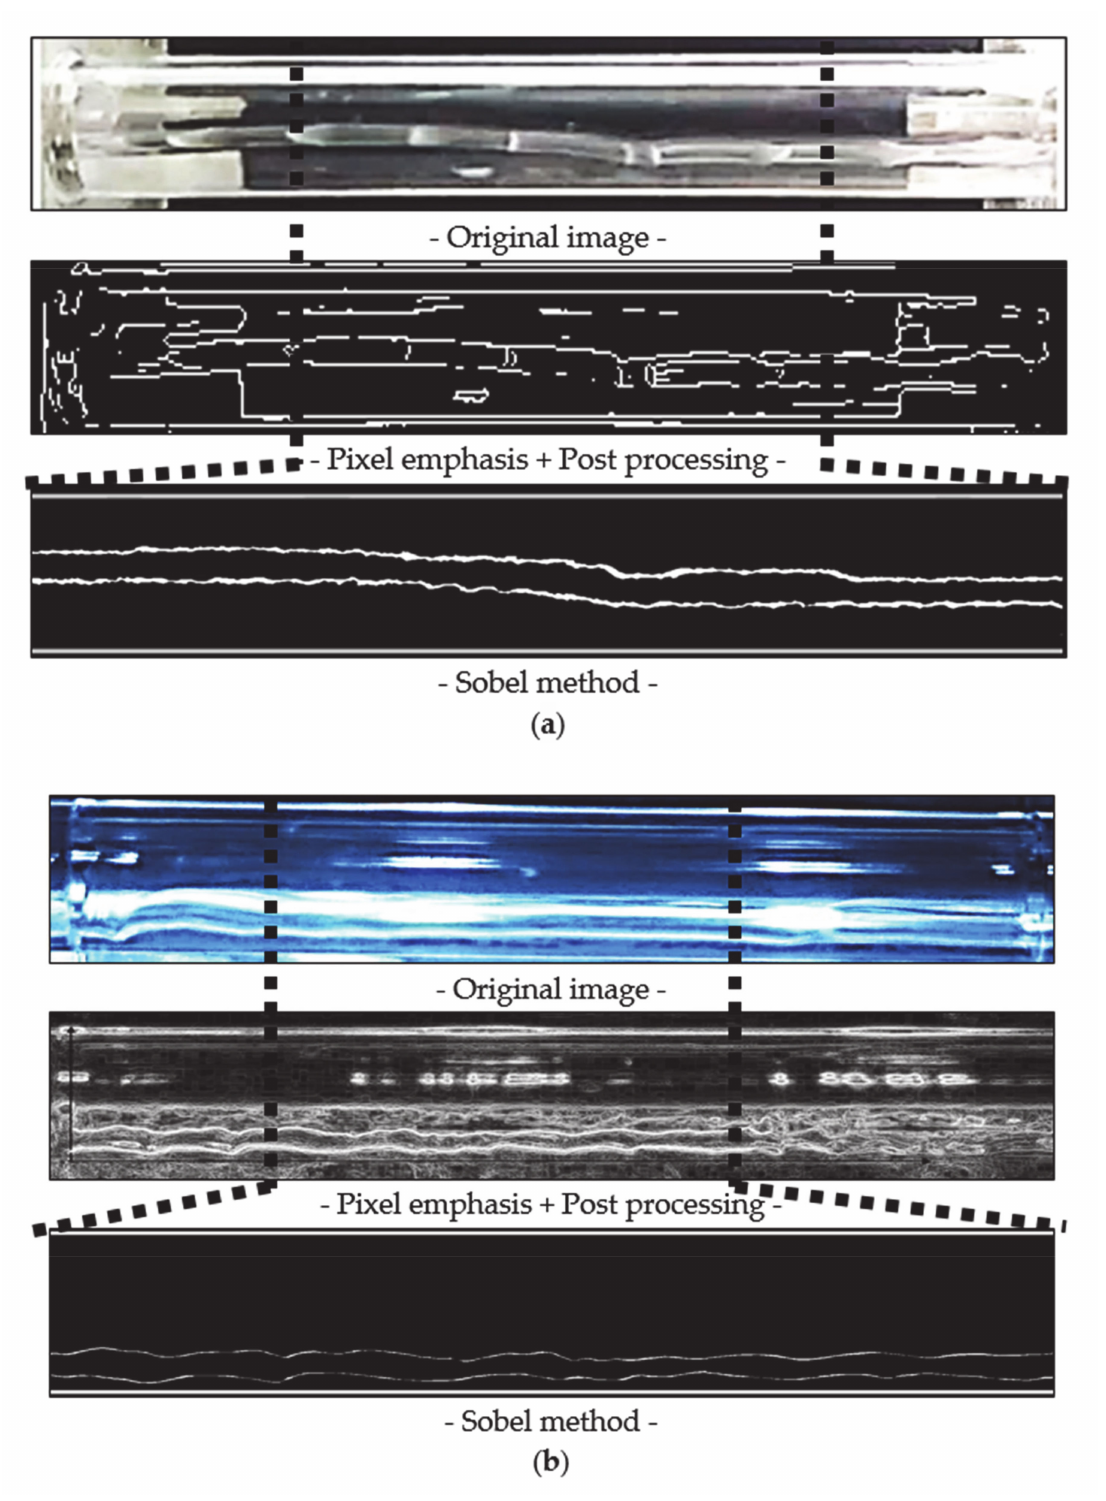
Figure 8. Results of visualization and image processing at ( a ) inlet section and ( b ) middle section. To evaluate the visualization experiments, the quality of the evaporator inlet part was compared to the results of the quality sensor, the results are expressed in Table 3. The sensor cannot be installed in the middle part of the evaporator due to the constraint of the refrigerator chamber. Maximum error between the visualization results and sensing value is 3.43% when the ambient temperature is 43 ◦